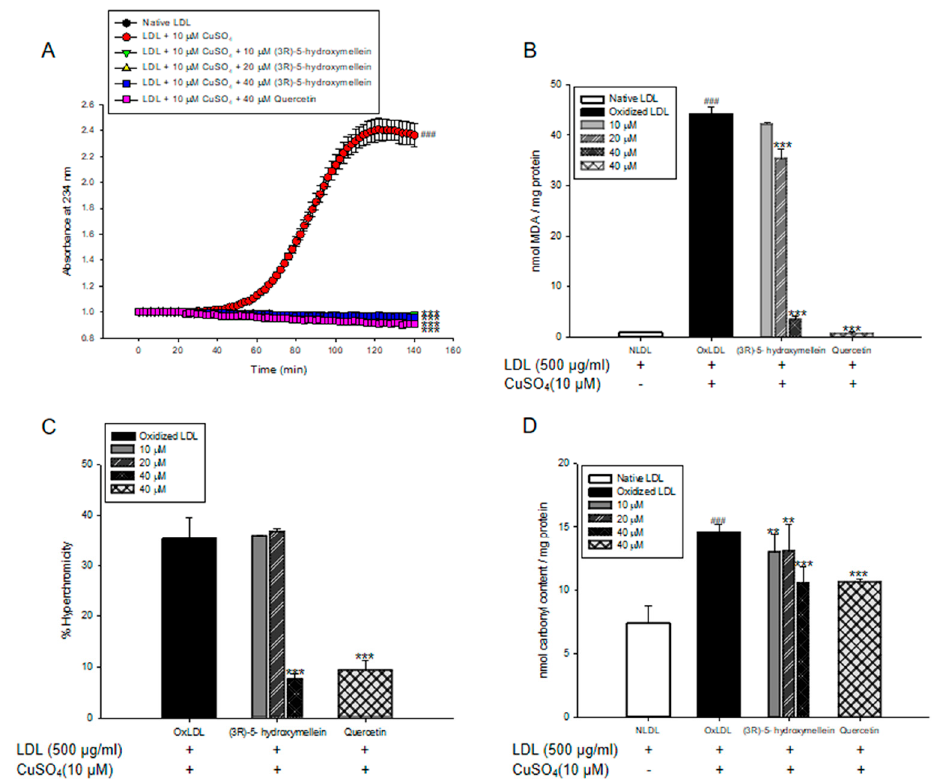
Figure 1. Effect of (3 R )-5-hydroxymellein on Cu2+-induced low-density lipoprotein (LDL) oxidation. ( A ) Continuous monitoring of the conjugated diene levels by absorbance at 234 nm (A234) during 10 μ M copper-ion-mediated LDL oxidation in the presence of (3 R )-5-hydroxymellein. ( B ) Effects of (3 R )-5-hydroxymellein (at 10, 20, and 40 μ M) in Thiobarbituric Acid Reactive Substances (TBARS) production during LDL oxidation induced by CuSO4 for 4 h at 37 °C. ( C ) Percent of hyperchromicity (absorbance at 280 nm) of oxidized LDL (oxLDL) and LDL treated with (3 R )-5-hydroxymellein (at 10, 20, and 40 μ M). ( D ) Carbonyl content determination of native LDL, oxLDL, and LDL treated with (3 R )-5-hydroxymellein (at 10, 20, and 40 μ M). Quercetin used as a positive control. These data are expressed as the mean ± SD of three independent experiments. ### p < 0.001 vs. NLDL (native LDL); ** p < 0.01 vs. oxLDL (oxidized LDL); *** p < 0.001 vs. oxLDL (oxidized LDL).